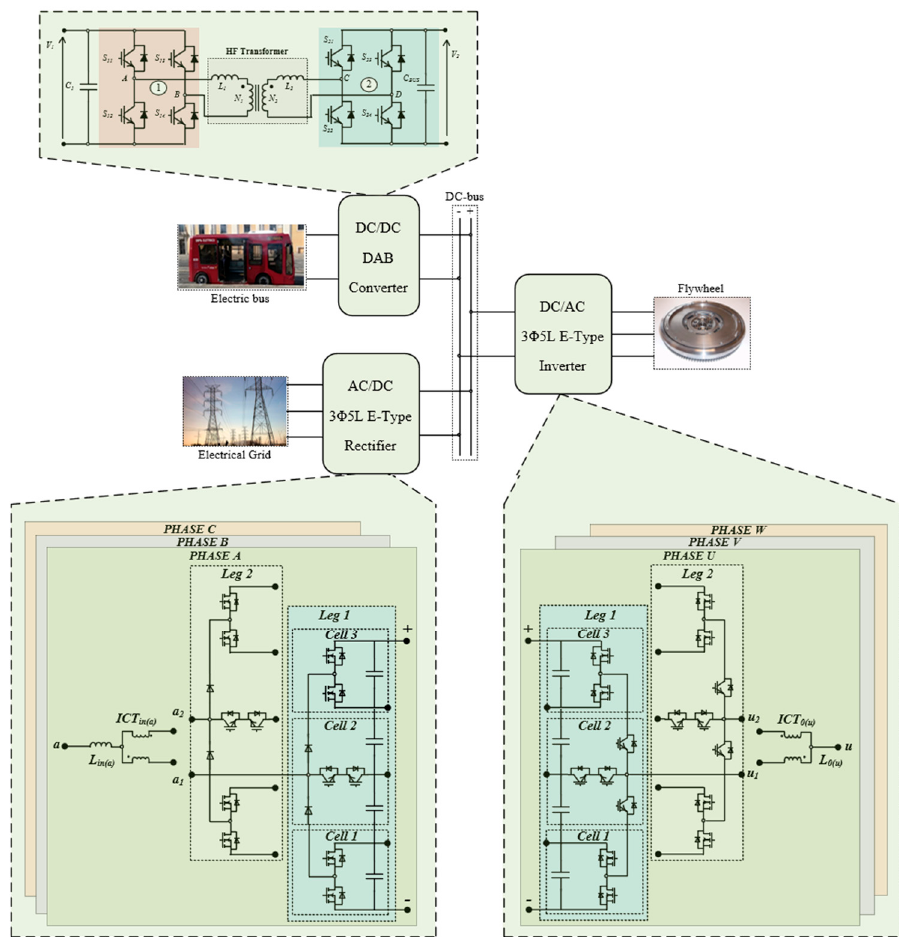
Figure 4. Block scheme of the proposed ultra-fast charging station.